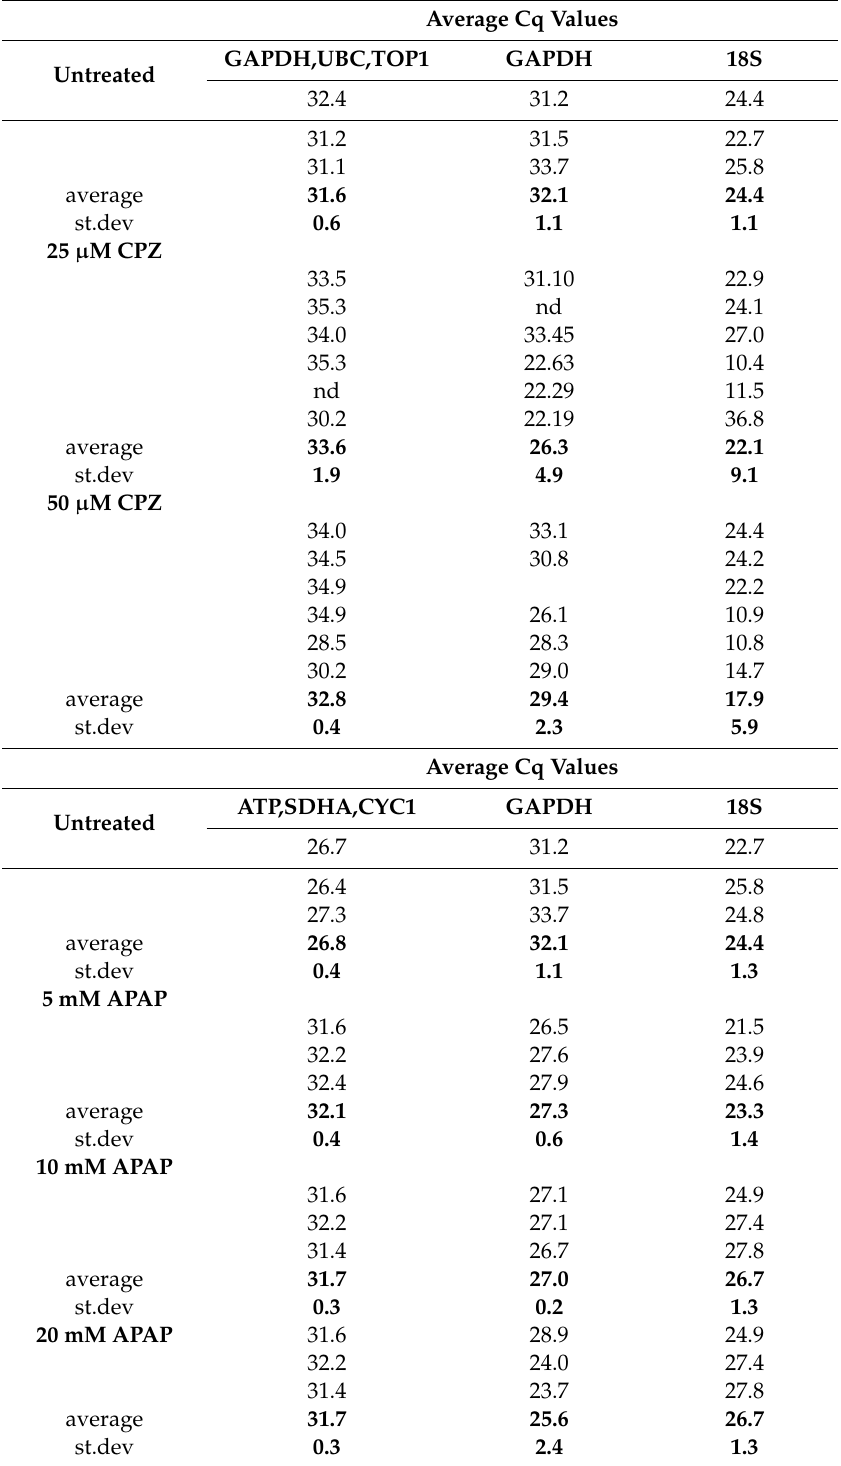
Table 4. RNA transcription level under CPZ or APAP stimulation for selected reference genes: (CPZ: GAPDH, UBC, and TOP1) or (APAP: ATP5B, SDHA, and CYC1) and single GAPDH or 18S